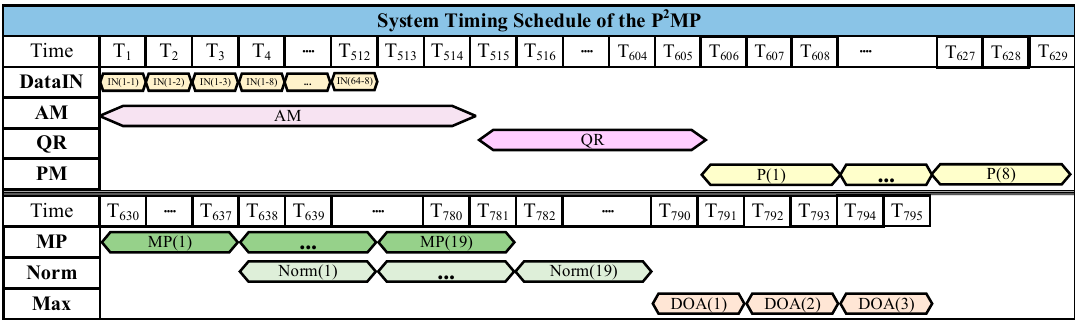
Figure 18. System Timing chart of the P 2 MP DoA estimation Hardware Design.